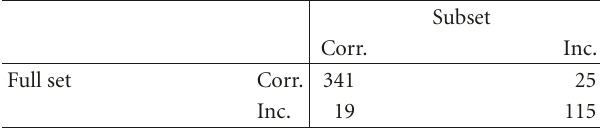
trix. The table of ANOVA is given in Table 12. From the